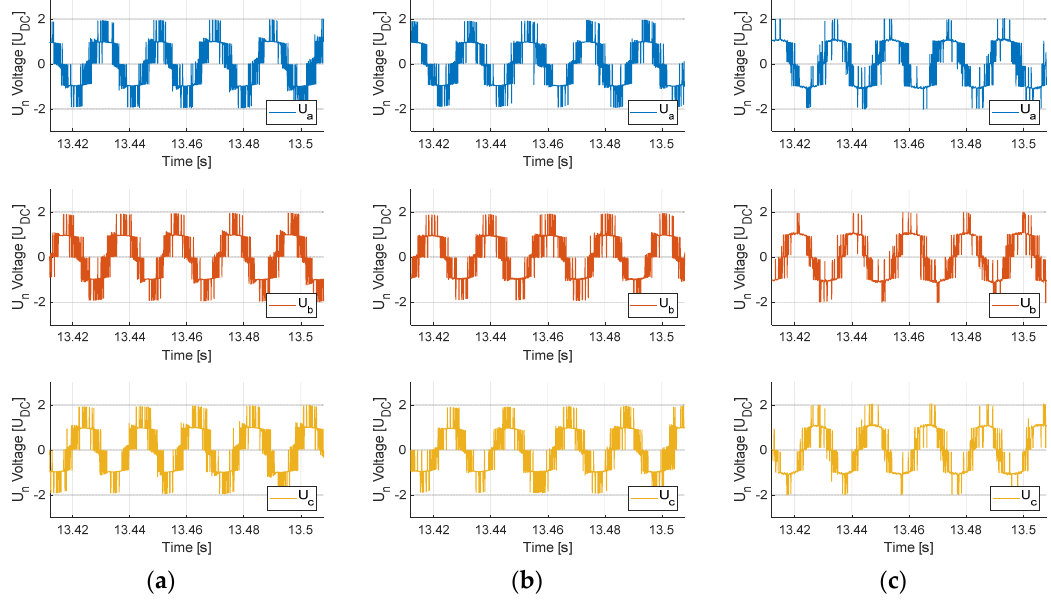
Figure 16. Three-phase synthesized STATCOM voltage: ( a ) CHB (4000 µ F ) ; ( b ) CHB ( 1200 µ F ) ; ( c ) CHB-SDC ( 1200 µ F )